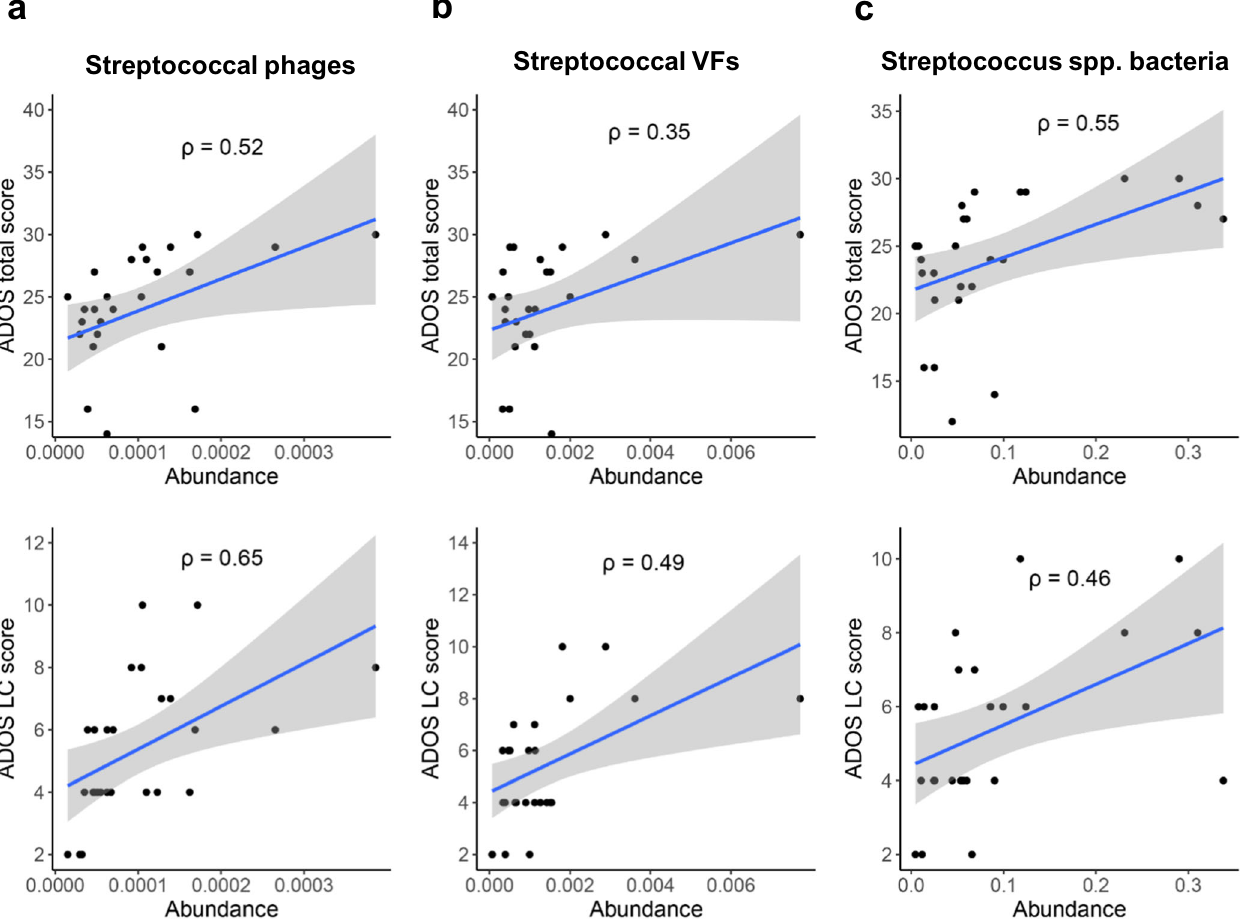
Fig. 6 Correlations between oral Streptococcal features and clinical manifestations of ASD. a – c The correlations of the oral abundance of Streptococcal phages ( a ), Streptococcal VFs ( b ), Streptococcus spp. bacteria ( c ) to the total and LC (Language and Communication domain) score in the ADOS evaluations. All correlations are tested using the Spearman rank test with the rho values labeled on each